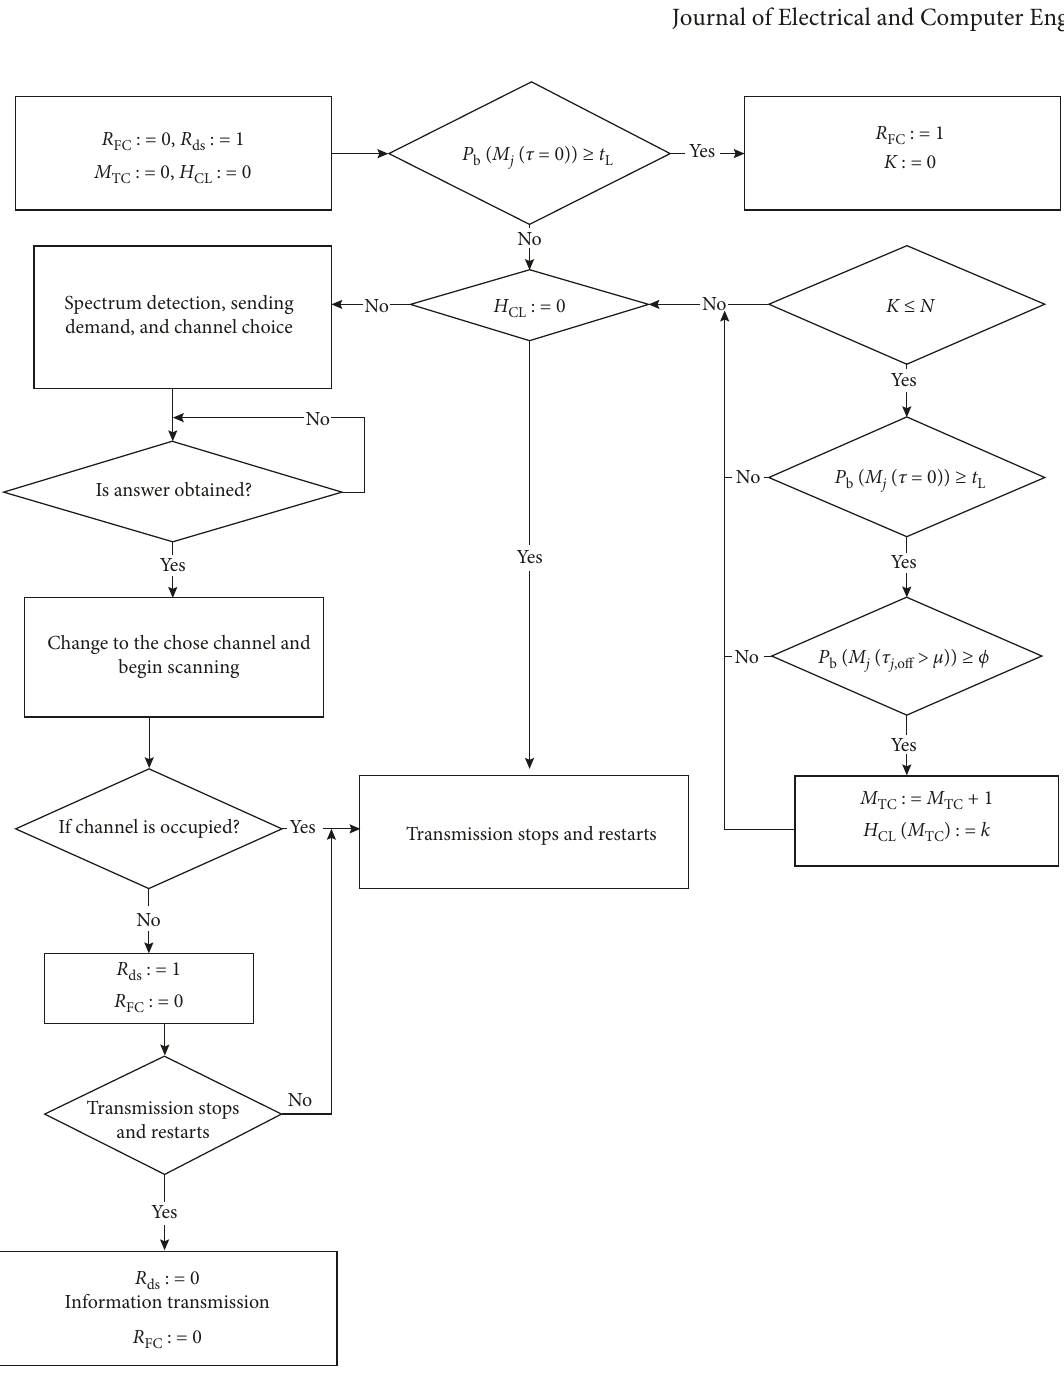
Figure 5: Protocol illustrating the steps of proactive spectrum